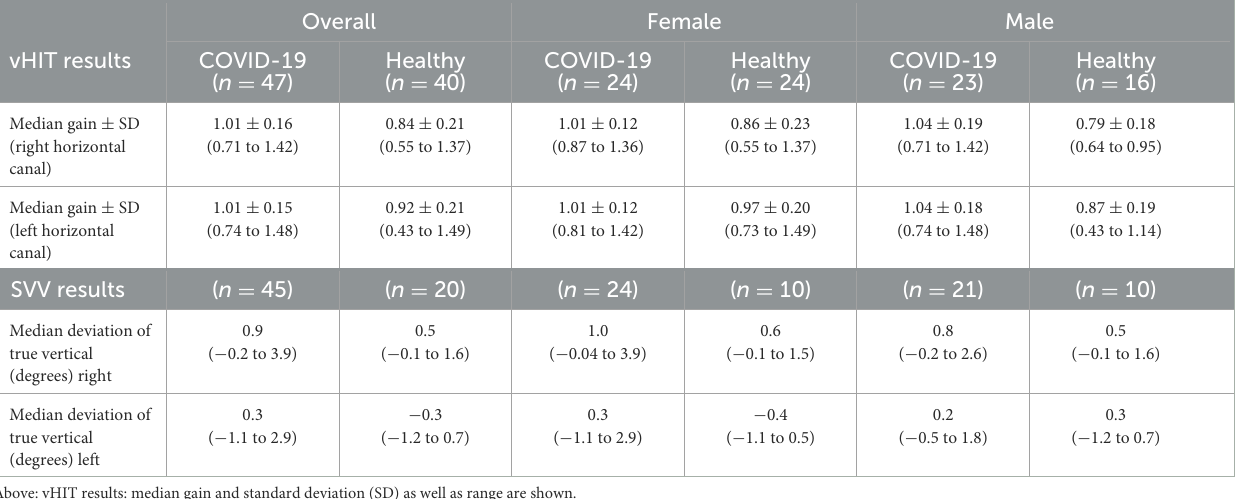
TABLE 3 Vestibular testing